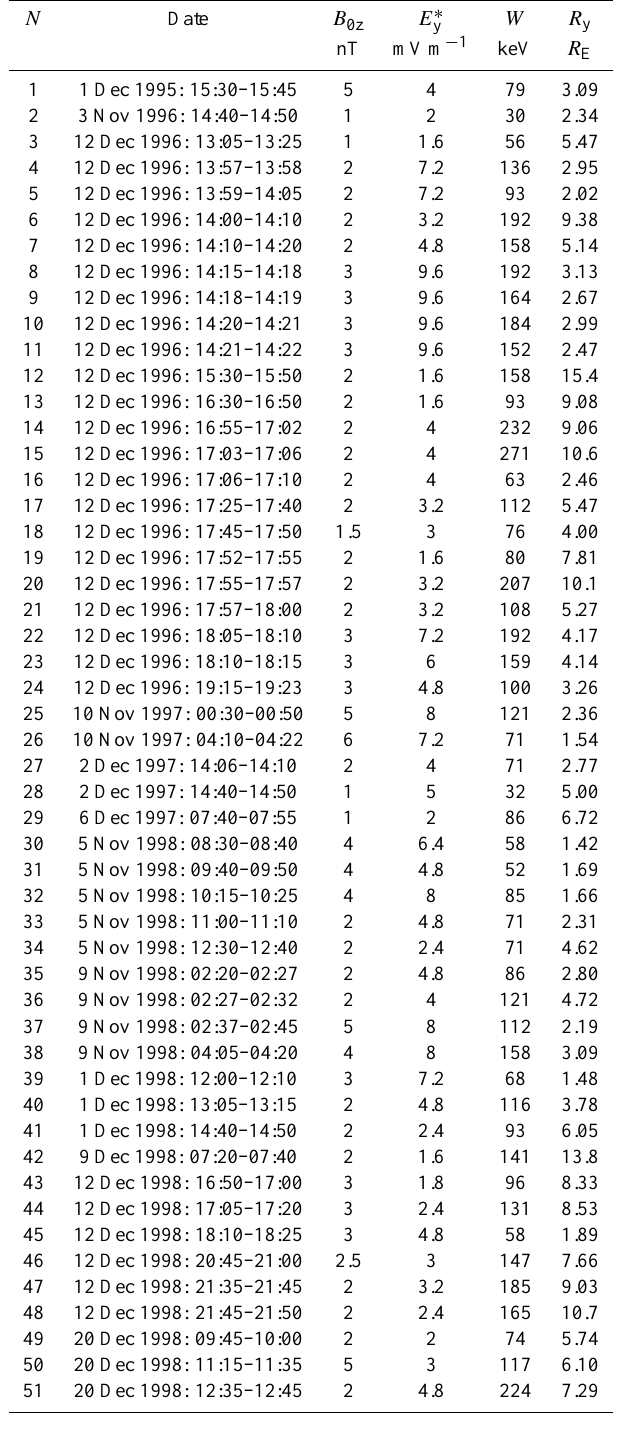
Table 1. The list of